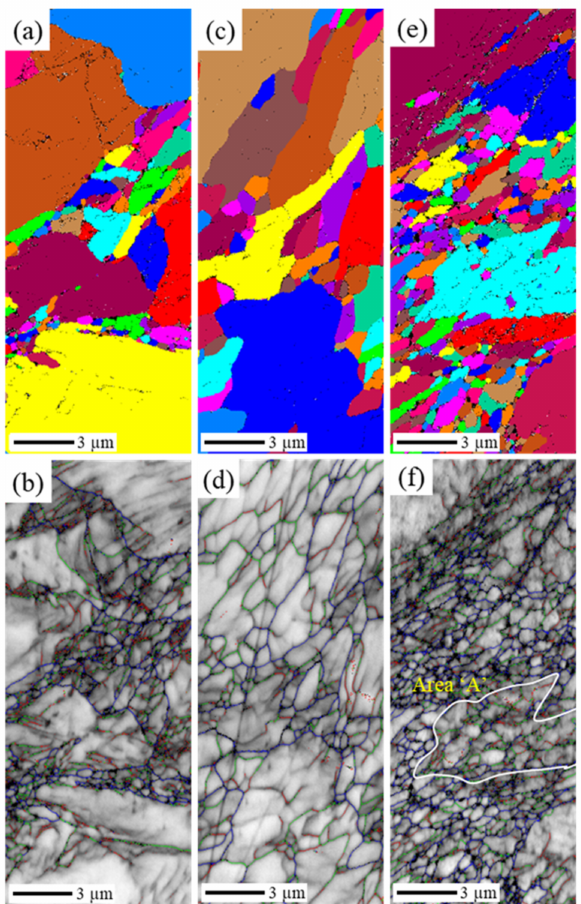
Figure 9. EBSD images depicting grain distributions after 1st heat treatment, measured from ( a , b ) the ECAPed specimen with a strain of 2.0, ( c , d ) the hot rolled specimen with a strain of 0.7, and ( e , f ) the hot rolled specimen with a strain of 2.0. Red, green, and blue grain boundaries indicate the misorientation angle of 2–5 ◦ , 5–15 ◦ and over 15 ◦ , respectively.